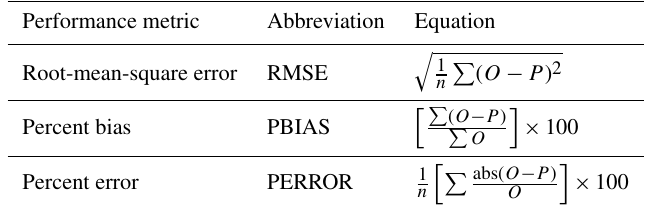
Table A2. Statistical measures of performance. Observed ( O ) and predicted ( P ) values are compared by each